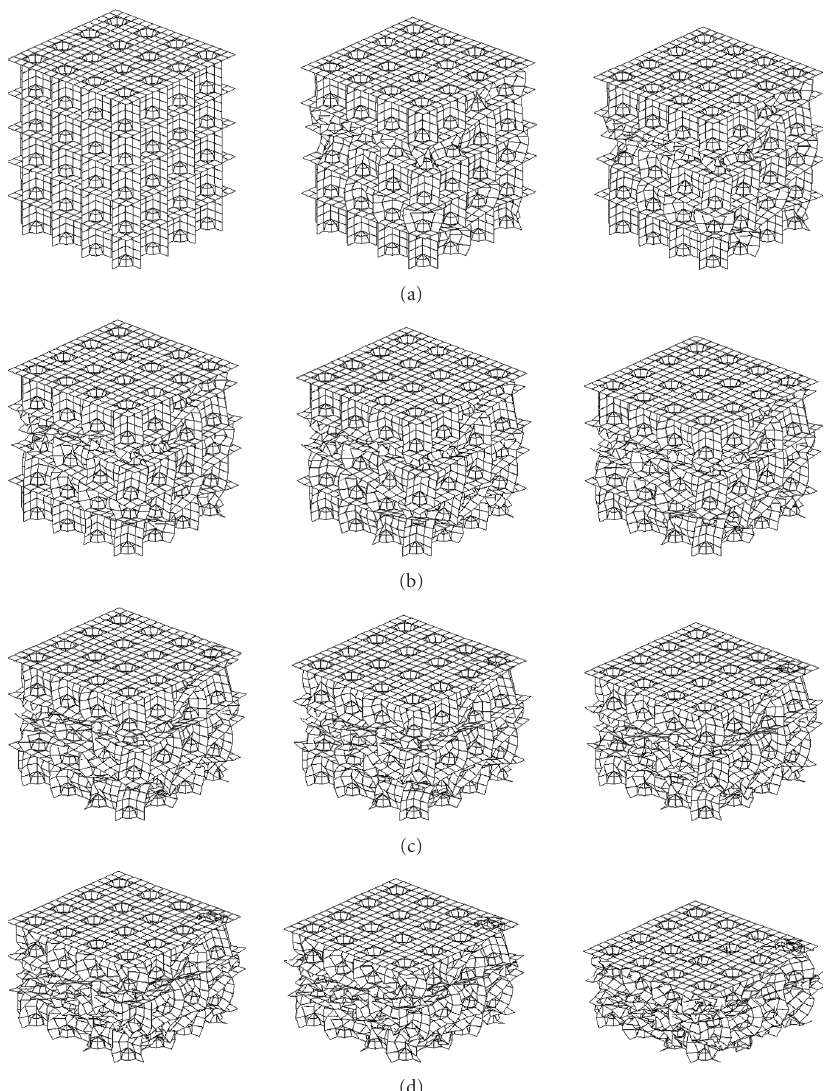
Figure 13: Isometric views of deformation pattern-III: deformation through irregular band formation, obtained from simulation when both the in-plane and through thickness density variations were implemented (same as the case presented in Figure